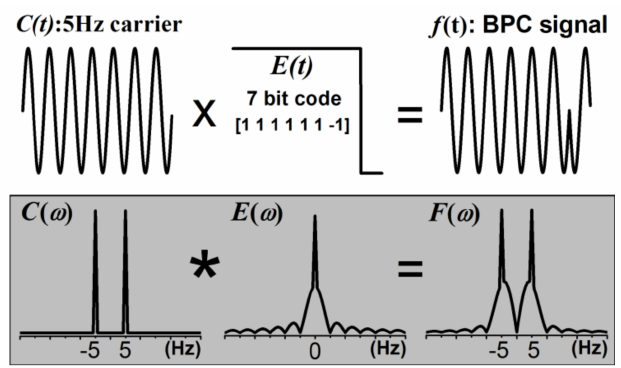
Figure 7. Schematic procedure of Binary Phase Coding (BPC) signal construction in time ( top ) and frequency ( bottom ) domains for a 7-bit code and 5 Hz carrier